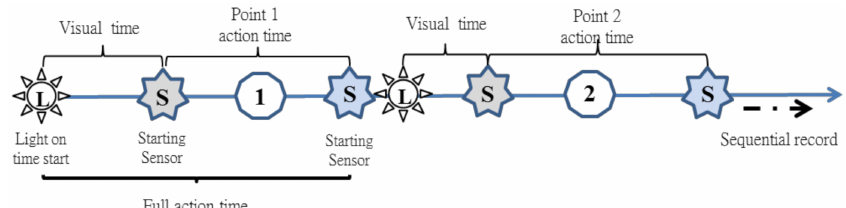
Figure 3. Architectural diagram of the wireless transmission system.